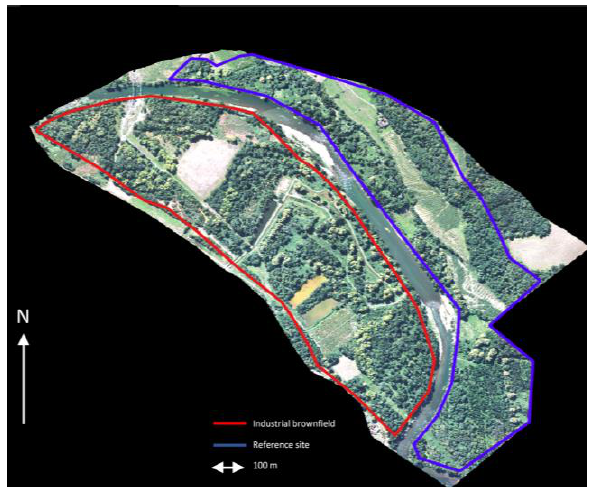
Figure 1 . Industrial brownfield (surrounded in red) and reference site (surrounded in blue) extracted from BD ORTHO® 25 cm.